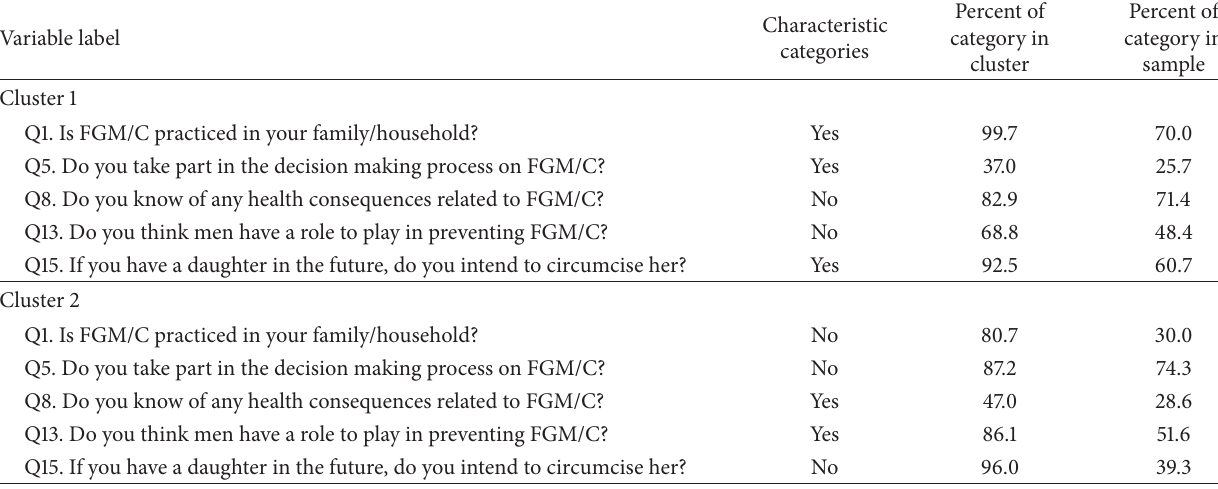
Table 6: Description of the clusters (active